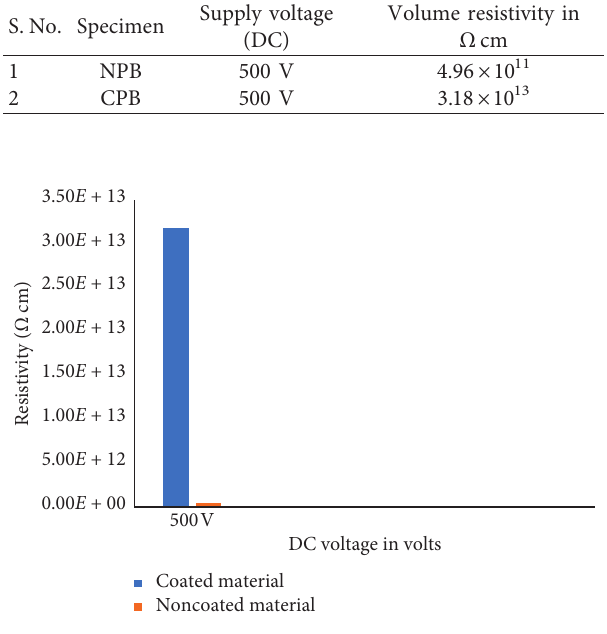
Figure 13: Volume resistivity of specimens (NPB and CPB) vs supply